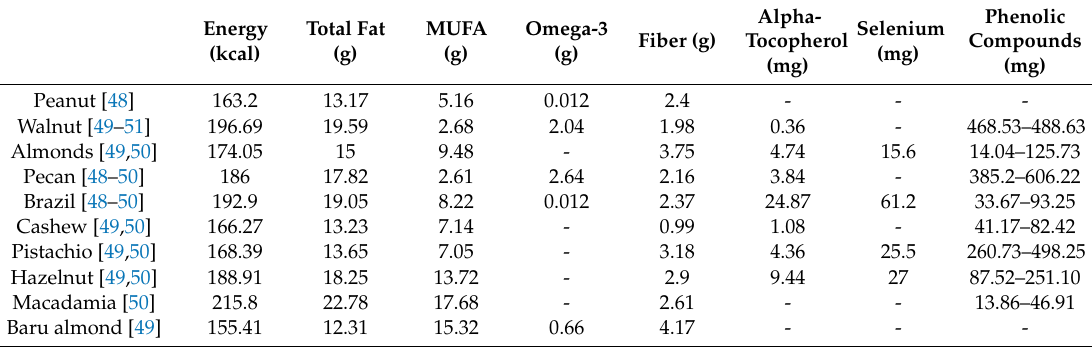
Table 1. Nutritional composition of di ff erent nuts in 30 g